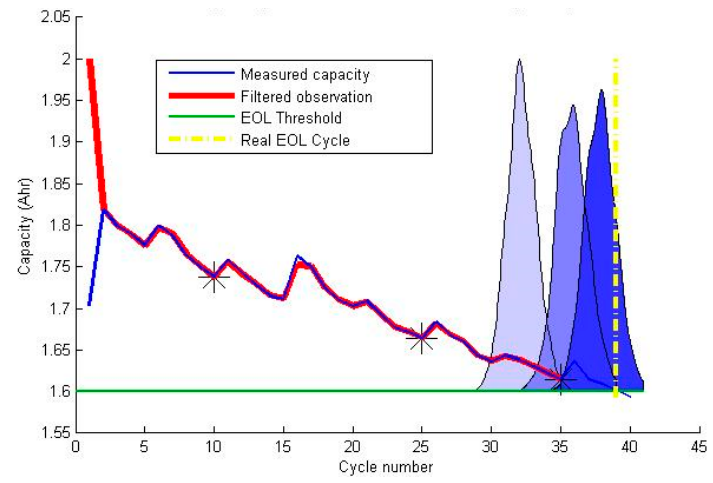
Figure 11. EOL prediction in cell B0007.